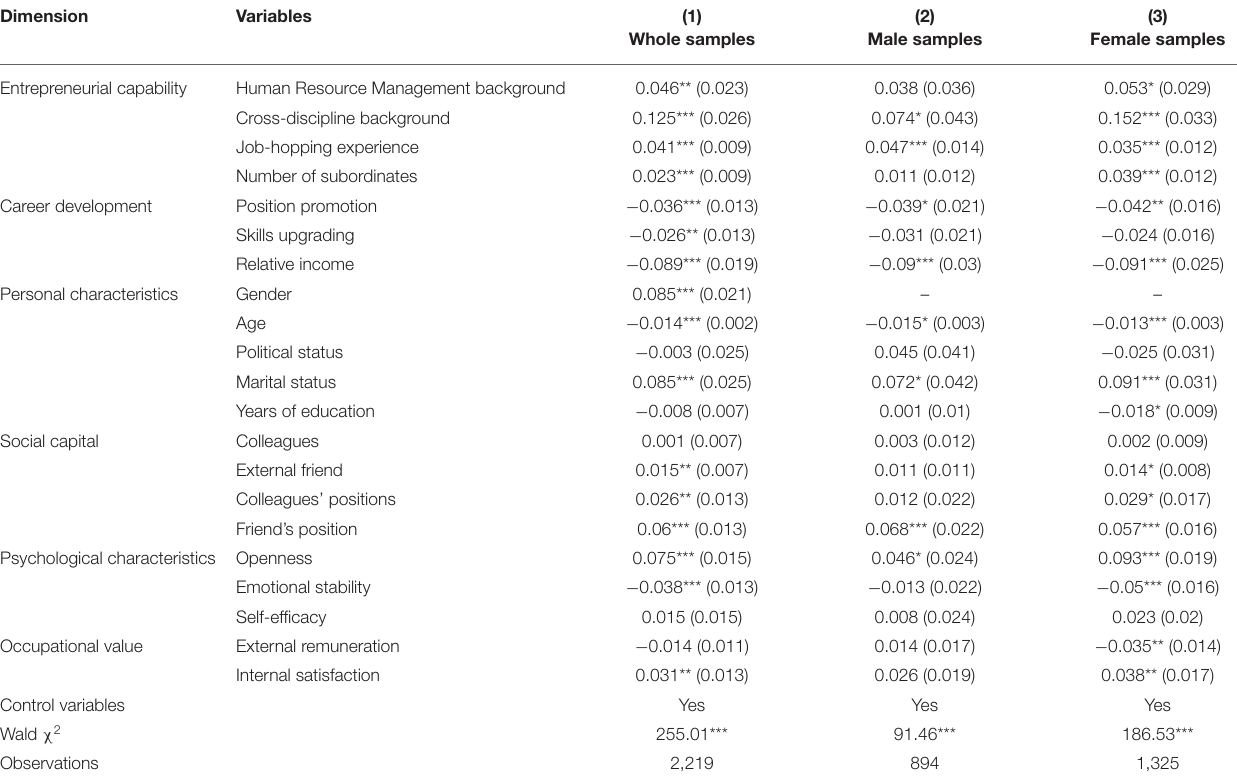
TABLE 3 | The impact of entrepreneurial capability and career development on entrepreneurial intention.